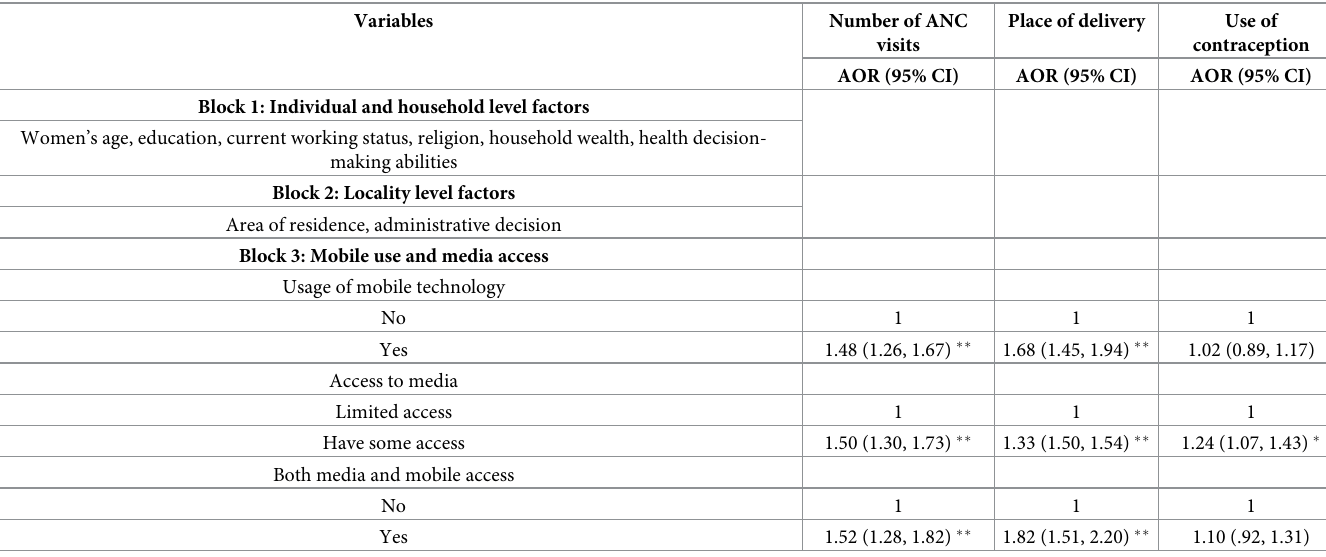
Table 5. Association of maternal health service use variables with mobile and media access factors controlling individual, household, and locality level factors.